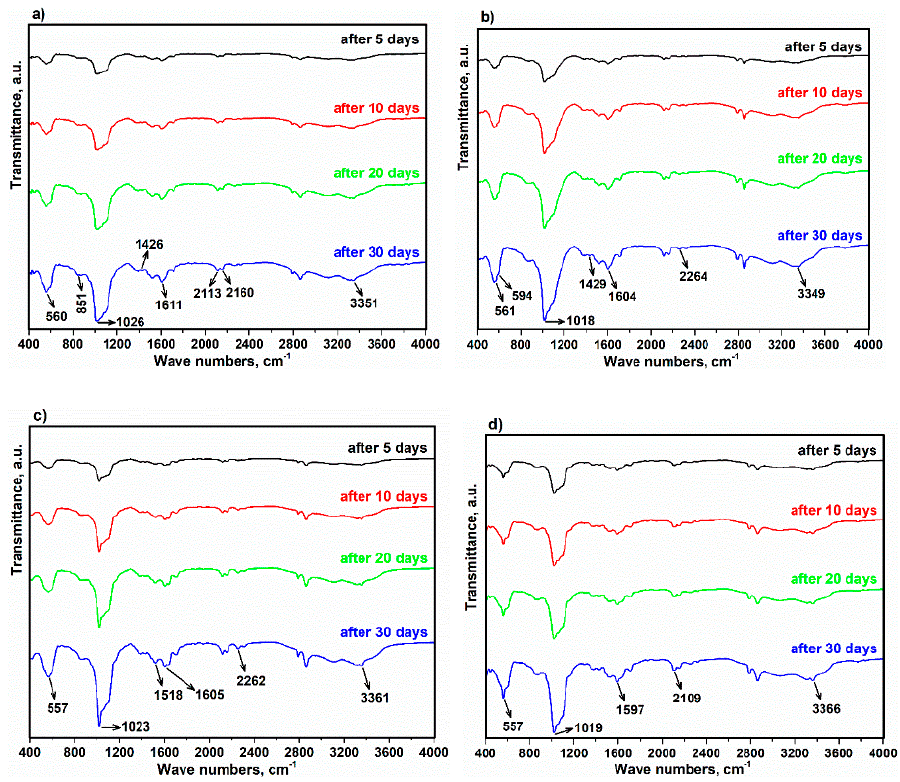
Figure 13. FTIR curves of immersed specimens in SBF after 5, 10, 20 and 30 days. ( a ) Alloy, ( b ) C1, ( c ) C2 and ( d ) C3.